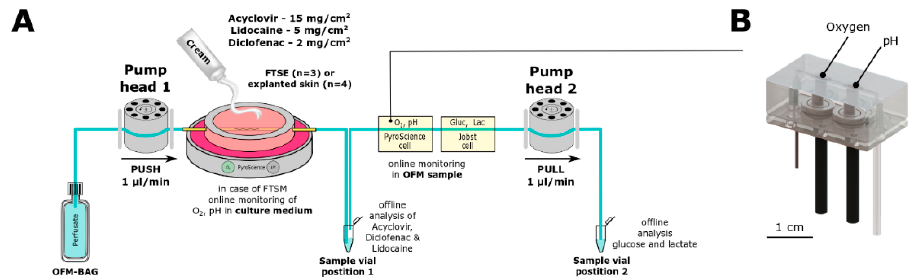
Figure 3. ( A ) Setup for penetration tests: Perfusate is pumped from OFM bag through OFM probe (yellow) implanted in FTSE with topically applied cream and withdrawn by pump head 2. OFM samples for offline analysis of acyclovir, lidocaine, and diclofenac concentrations were collected at position 1. OFM samples for the offline analysis of glucose and lactate were collected at position 2. ( B ) Custom-made microfluidic flow-through cells for online monitoring of oxygen and pH: connection with tubing and optical fibers for data read out.